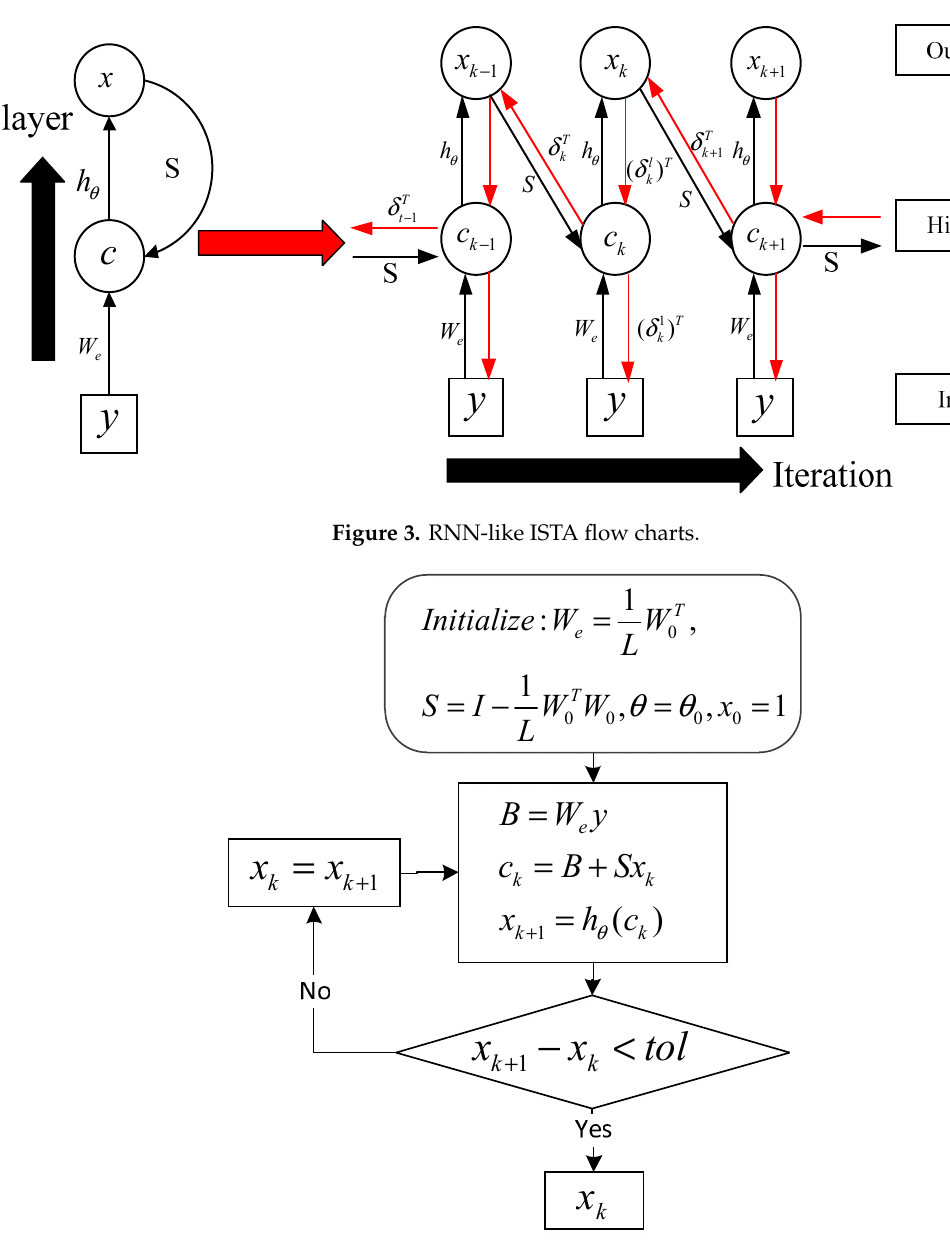
Figure 4. Flowchart of forward calculation using the improved ISTA.